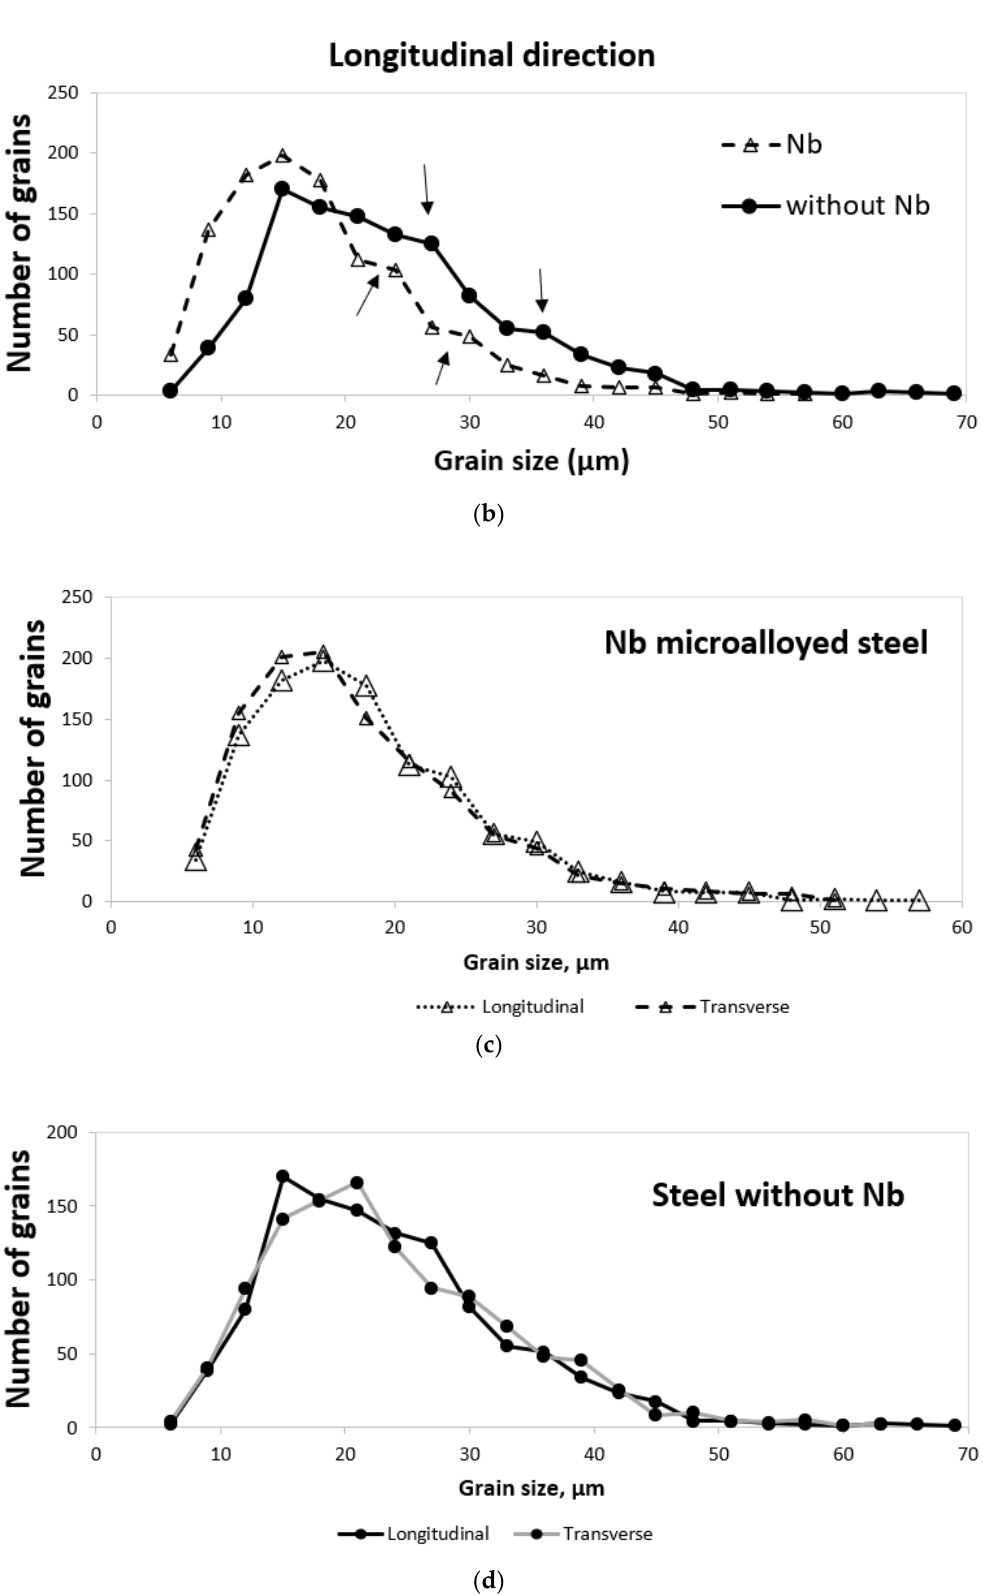
Figure 8. Frequency distribution of FG size evolution for 0 Nb and 240 Nb: ( a ) transverse (T) and ( b ) longitudinal direction (L). ( c ) An FG comparison evolution based on the T-L directions for 240 Nb. ( d ) An FG comparison evolution based on the T-L directions for 0 Nb.